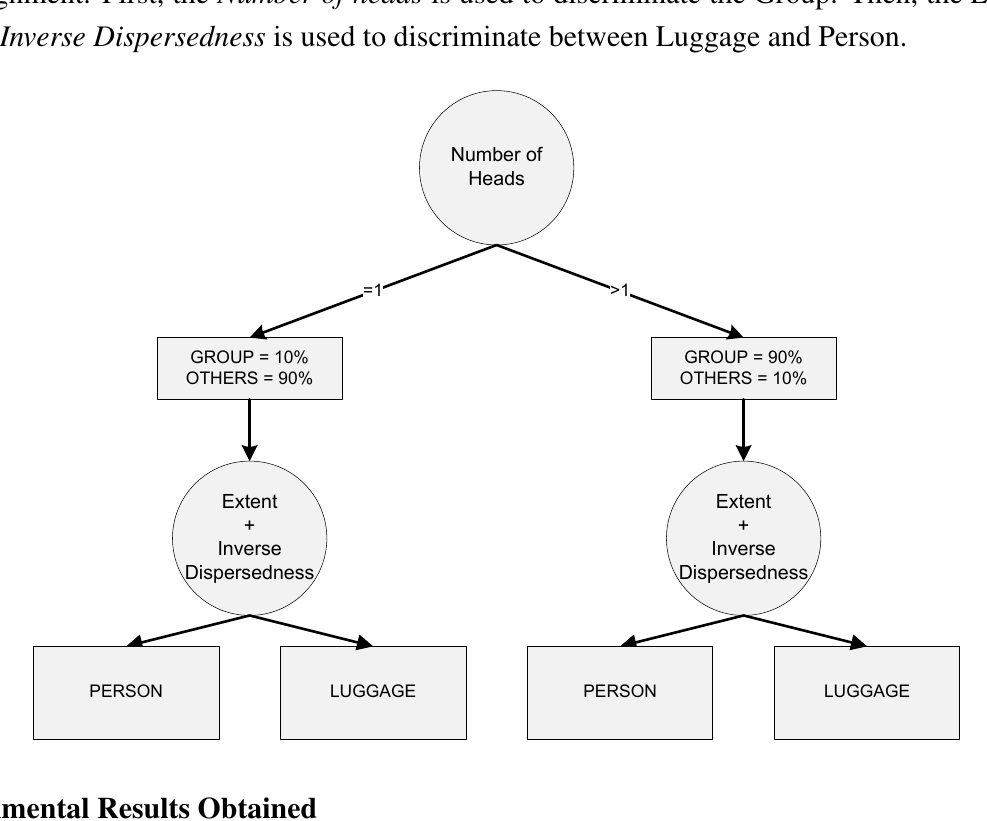
Decision tree used in low-level classification for membership